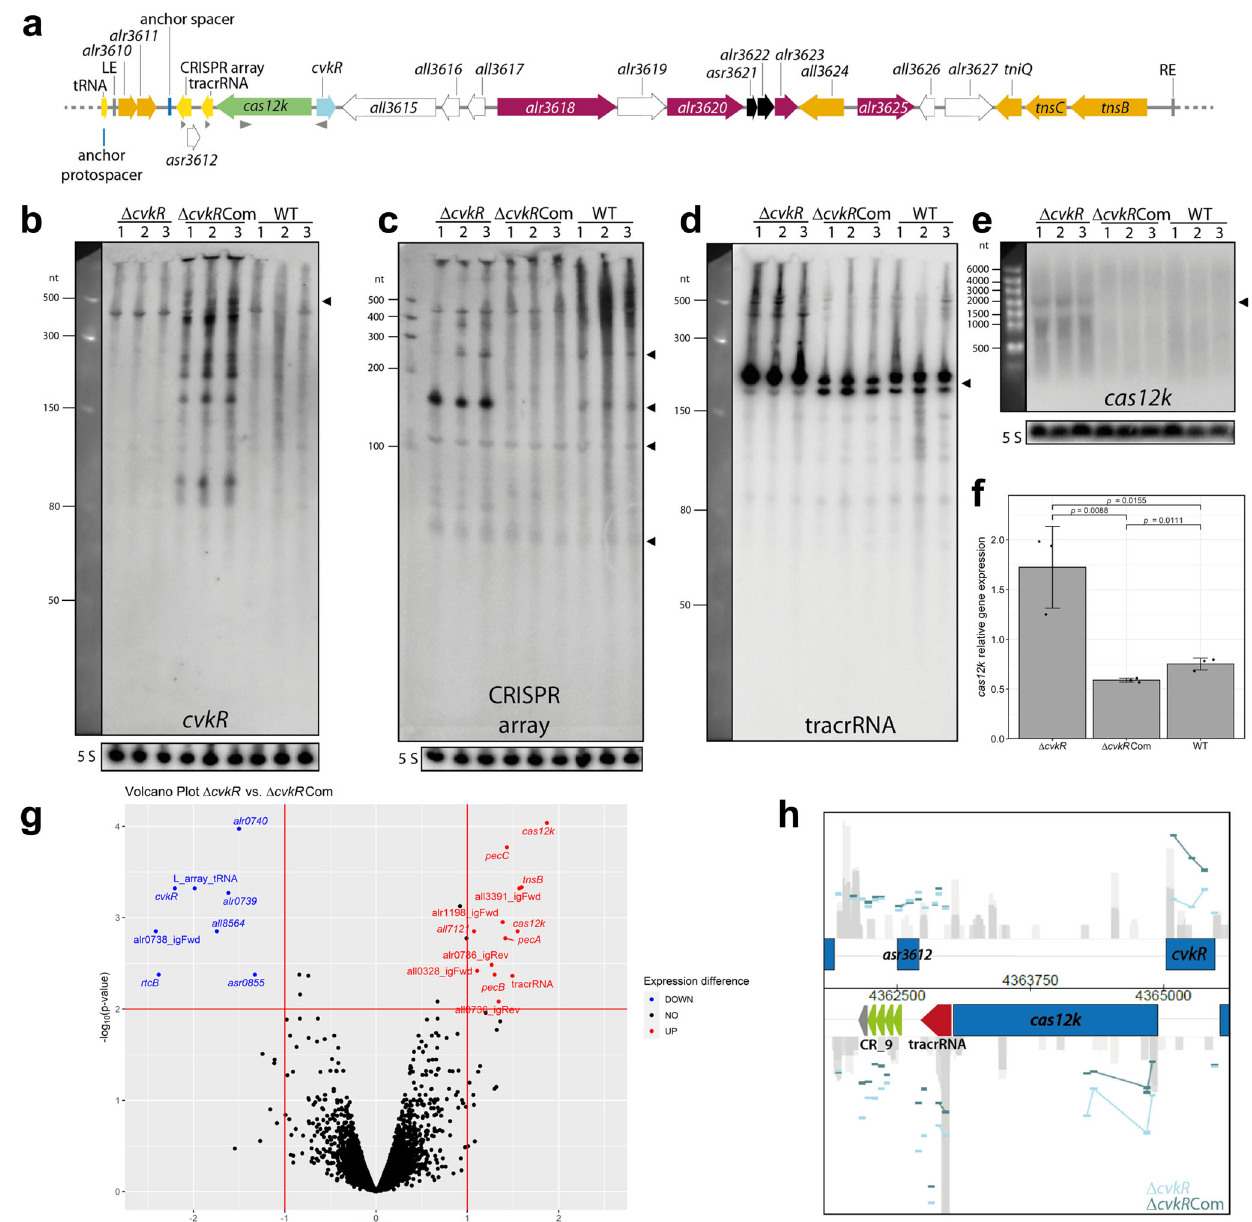
Fig. 4 | The Anabaena 7120 CRISPR-associated transposase system (AnCAST) and the effects of cvkR deletion and overexpression. a Genes within the 24,963 nt AnCAST include cvkR encoding a transcriptional regulator, cas12k encoding the effector,severalcargo and Tn7 genes. Gray trianglesindicate hybridization probes used in b – e . RM genes are colored magenta, a toxin-antitoxin module black, other gene functions as in Fig. 1. b to e Northern hybridizations for the cvkR mRNA, the CRISPR array, tracrRNA and cas12k as indicated. Triangles indicate the expected lengths for cvkR , for the CRISPR array (entire length ~250nt, two repeat-spacer units ~140nt, partially processed two repeat-spacer unit ~100 nt, single repeat- spacer70nt),thetracrRNAand cas12k ,ageneof1.92kb.Gelsandmembraneswere checked for equal loading by ethidium bromide staining and hybridization to the 120 nt 5S rRNA (in b and d the same membrane was hybridized). The Low Range ssRNALadder(NEB)wasusedassizemarkerin b and d ,theRiboRulerLowandHigh Range RNA Ladders (Thermo Fisher Scienti fi c) in c and e . Twenty micrograms of